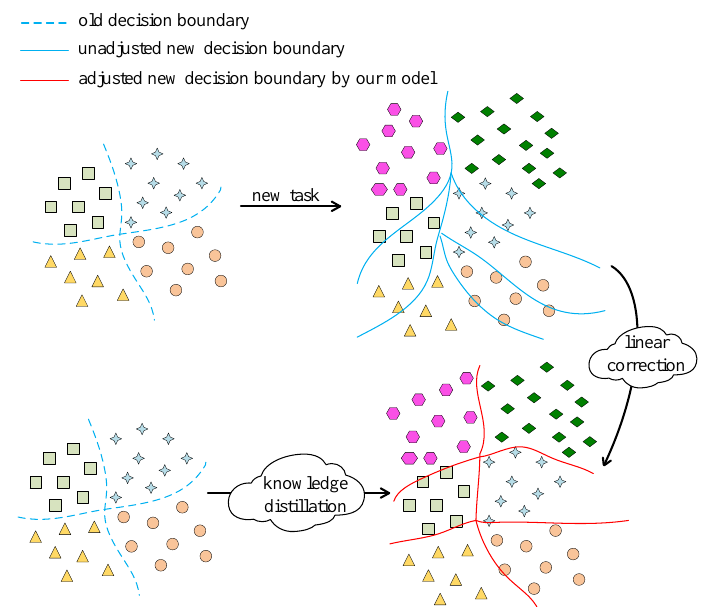
Figure 1. Illustration comparing the traditional learning approach and the proposed scheme of our model: Traditional classification methods suffer from catastrophic forgetting; the old decision boundary will change significantly ( top ). The proposed model utilizes knowledge distillation to transfer old knowledge to the new network and utilizes linear correction unit to adjust and correct the decision boundary ( bottom